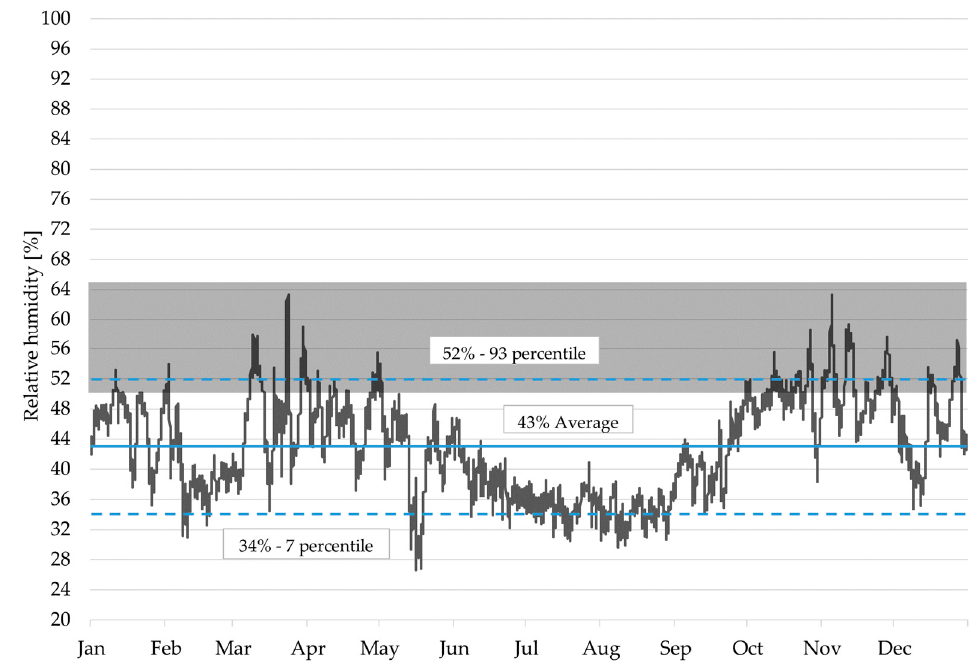
Figure 25. Trend of historic climate hourly values of RH and statistical limits of 93rd and seventh percentiles in room XXII vs. the range recommended by the Italian D.M. 10.05.2001 [16] (gray band).